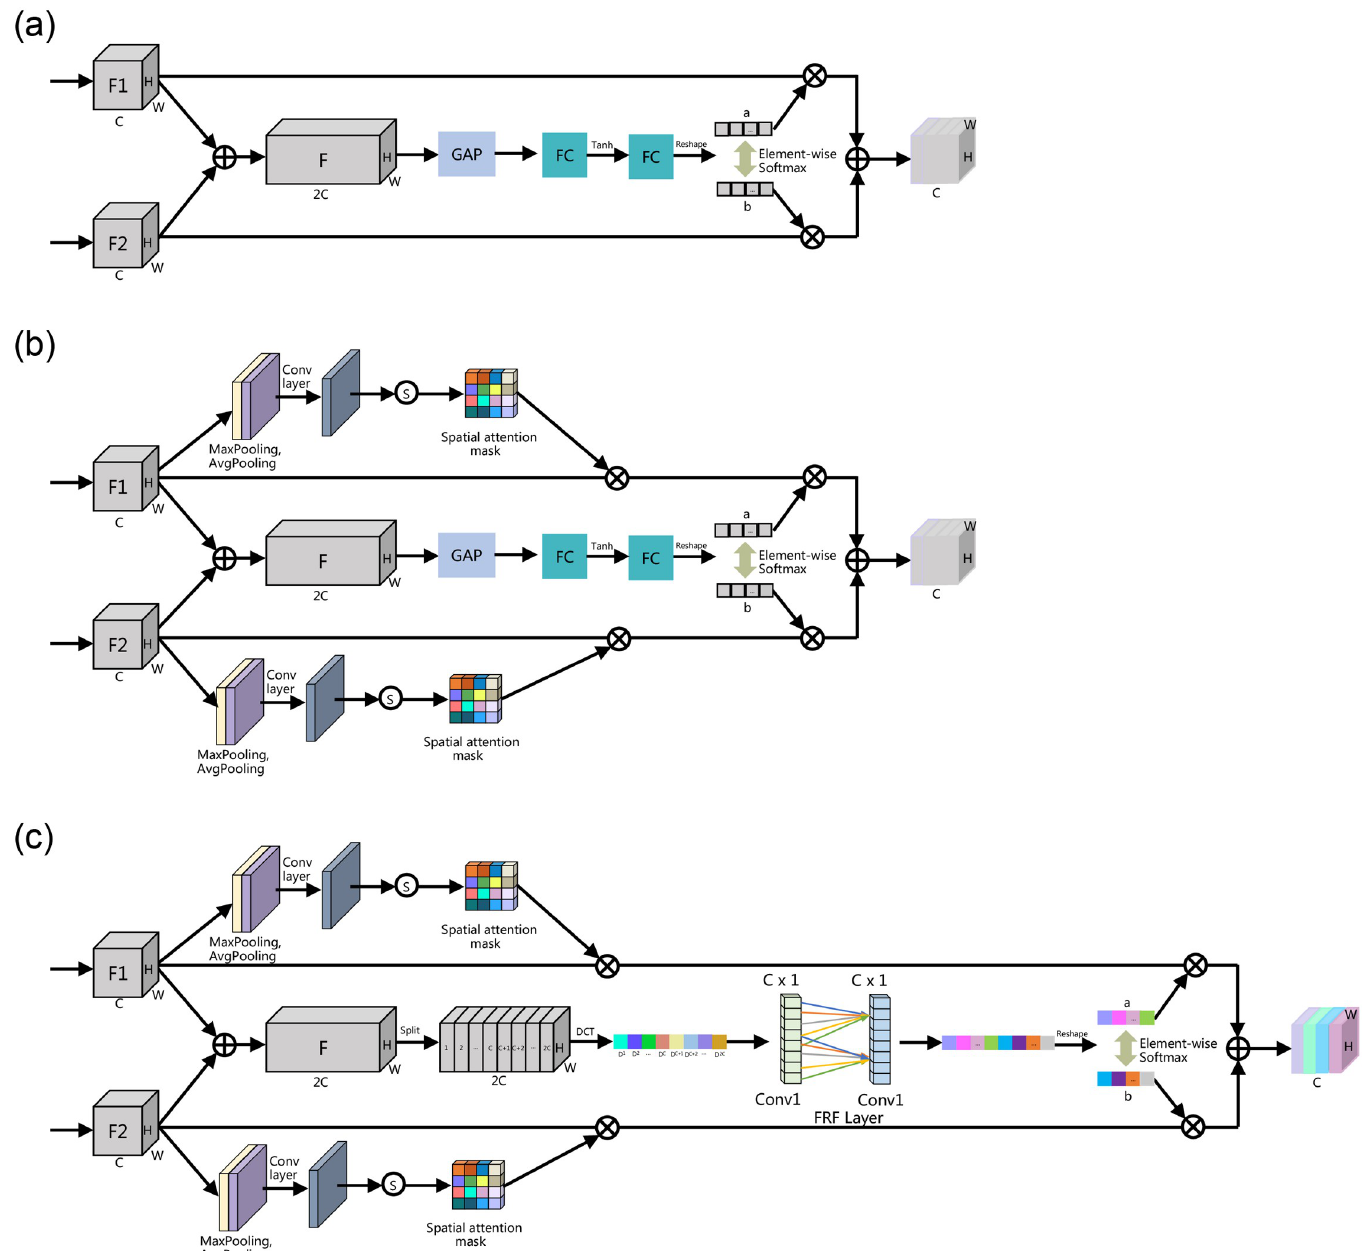
Fig 4. Three different feature fusion